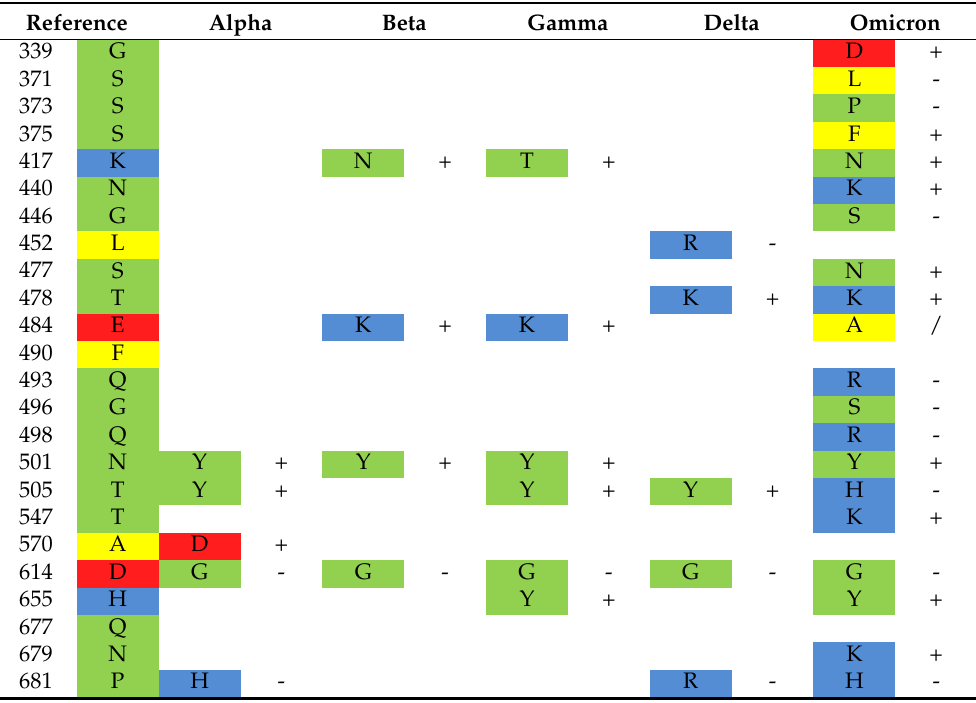
Figure 1. Neutrality substitution test from the S protein of Omicron variant (red line) compared to the previously reported neutrality test of the SARS2-S VOC sequences reported before June 2021 (blue line) (data obtained from our previous work [16]). The negative control (black line) shows the expected probability of amino acids occurring by random mutations. The probability of occurrence of each amino acid of the proteins was calculated with a confident interval of 95%. Amino acids showing a probability of occurrence different from the expected control are under selective pressures, either positive or negative. Table 1. Mutations of each VOC at the RBD until the furin cleavage site. Mutations are shadowed by the chemical characteristic of the residue: yellow—non-polar, green—polar uncharged, blue—polar positively charged and red—polar negatively charged. The symbol next to each residue refers to the type of selective pressure exerted over that amino acid; thus, + is positive selective pressure, - is negative selective pressure, and / is for neutral